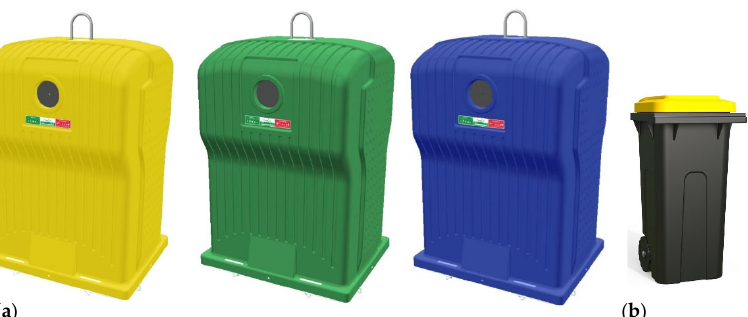
Figure 3. Example of drop-off containers ( Ecopoint ), Cyclea , currently used in most municipalities in Portugal [33] and selective collection door-to-door [34]. Likely, the growth registered in the year 2019 and the rise in the packaging recycling rate to 63% of recycled waste is due not only to the awareness of the need to recycle it (placement of recyclable waste at collection points) but also to the possibility of doing it right at the source after the consumption of the goods in our home (promoted by door ‐ to ‐ door collection), and perhaps because of the greater availability to do so in times of confinement. This change of behavior with regard to the daily selective collections (interspersing the commingled waste collection with the collection of packaging, paper, and glass), triggered the need to create a very careful planning of the logistics systems of collection, storage, and processing. It should also be noted that the entire responsibility for the waste management methods and strategies [35] (“ control, collection, transfer, processing, and disposal waste, with a target to minimize the reduction on landfills, along with material recovery/recycling – target set by the European Green Deal and Circular Economy Strategy ” [36]) falls on the municipalities or inter ‐ municipalities; therefore, all investments and costs of the recycling process are centralized. On the other hand, as processing costs are fixed, it will be in the logistics system of waste collection that most of the gains or losses may fall. Thus, an improvement, a reduction in the costs associated with the activity, will involve changing and optimizing the routes, making them more comprehensive, changing the carrying capacity of the vehicles, or reducing the number of weekly collections per ton of waste collected. The literature review on the subject presented in this work, in the most diverse databases, returned few references related to compaction and compaction devices for small waste containers. These include a study presented by Xevgenos et al. [37] who proposed an innovative project: a portable device for a miniature separator/compactor, developed for the household separation of urban solid waste based on a hydraulic piston system. Although this approach can result in a substantial reduction in the volume of domestic solid waste deposited, with compression rates between 7 and 22% [20], the acquisition of the proposed hydraulic compaction equipment for individual use at home would result in a high investment which is inaccessible to a large part of domestic producers. Another study by Pace et al. [38] analyzed a heat melting compaction device developed by NASA to melt the plastics in the waste collected and encapsulate the waste in it. However, this kind of device does not allow for easy recycling of the waste collected as the plastics are melted and combined in an undistinguishable material. Furthermore, it cannot be applied to compact metals, due to the higher pressure needed to compact this material. The use of compaction devices has been advocated only in the collection or in the transportation vehicles [39]. Therefore, an intermediate and proximity solution, where the compaction device is installed in a container for collecting community waste, i.e., in